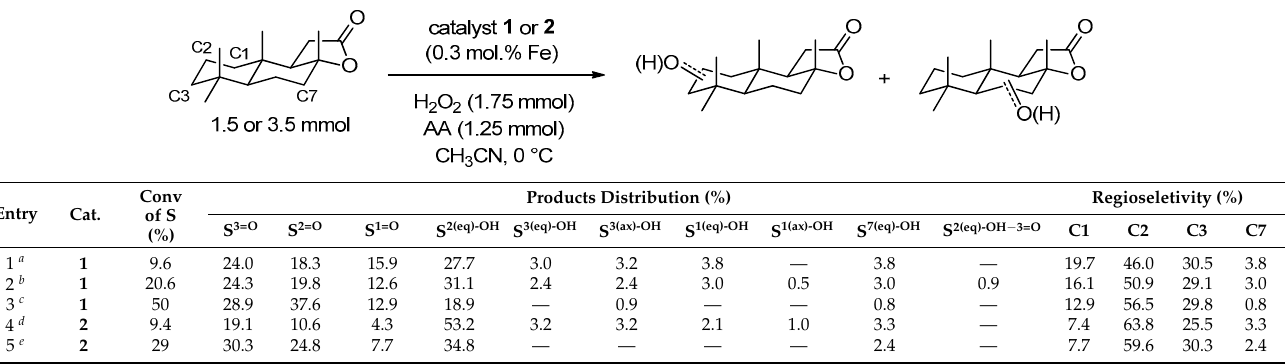
Figure 5. Structures of major and minor products of oxidation of (3a R )-(+)-sclareolide. Table 3. The effect of HClO 4 on the product distribution of oxidation of (3a R )-(+)-sclareolide with H 2 O 2 in the presence of complexes 1 and 2 .